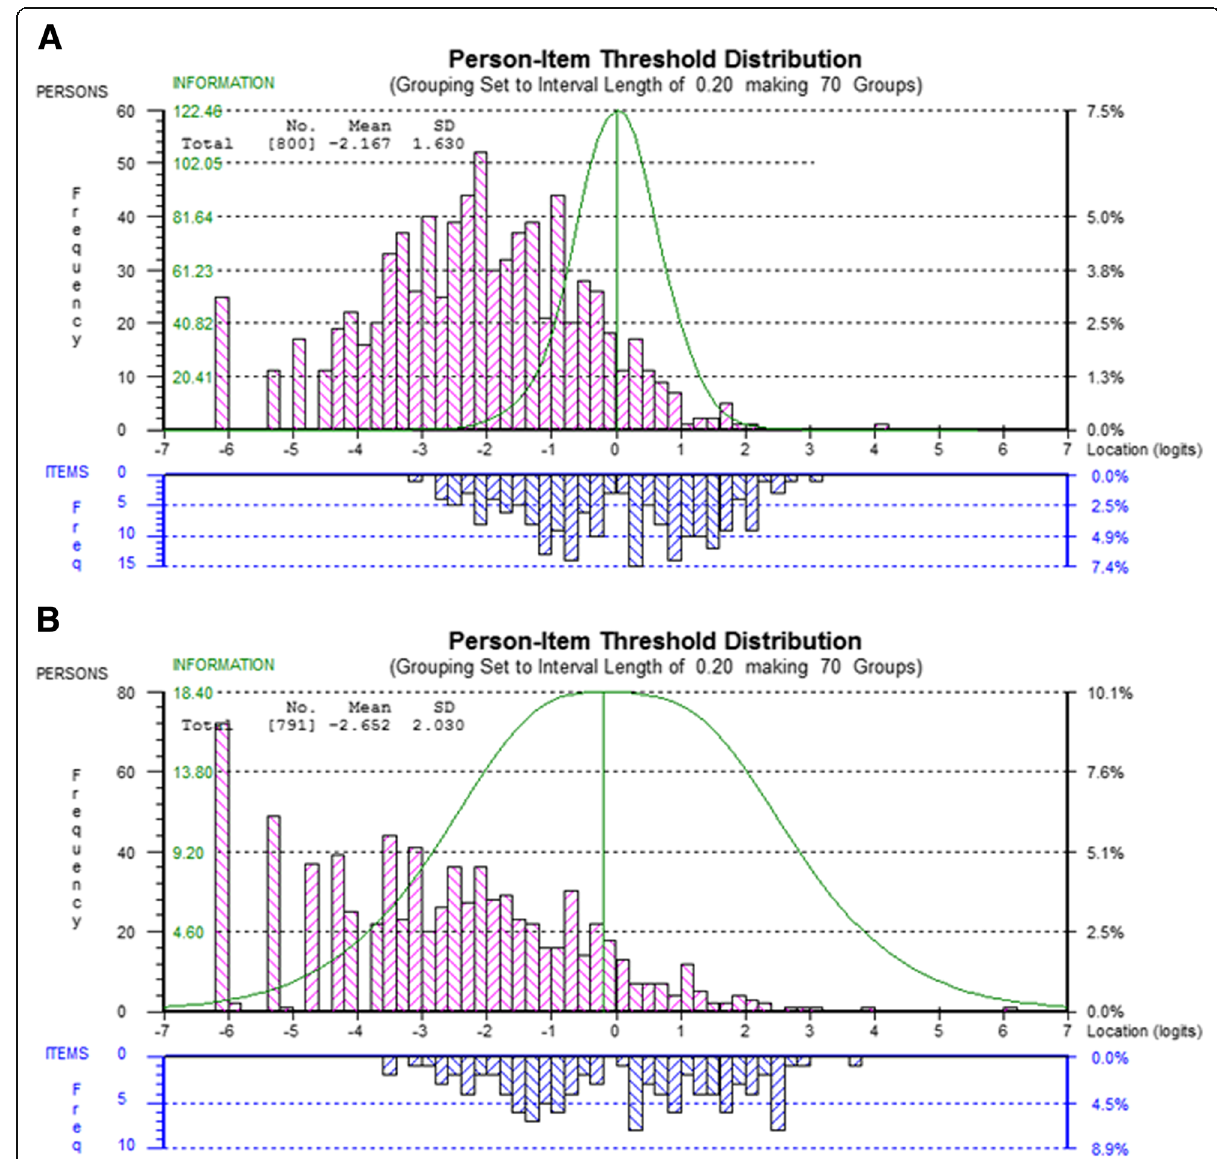
Fig. 1 Scale-sample targeting: top histograms (pink bars): sample ’ s distribution of depression measurements (person locations) measured by the PROMIS 51 items in ( a ) and the PROMIS 28 in ( b ). Person measurements reflecting lower ability (lower depression) are represented by histogram bars on the left and person measurement reflecting higher ability (higher depression) by the histogram bars on the right. Lower histograms (blue bars): scale distribution of item threshold location estimates for the 51 items in ( a ) and the 28 items in ( b ). Histogram bars on the left represent the easiest items (requiring lower levels of depression to be positively endorsed) and histogram bars on the right represent the more difficult items (requiring higher levels of depression to be positively endorsed). Green curve: represent an inverse function of the standard error associated with measurement, it reflects scale ’ s precision and shows the location on the continuum the scale performs at its best, indicating that the location of item thresholds and persons is well